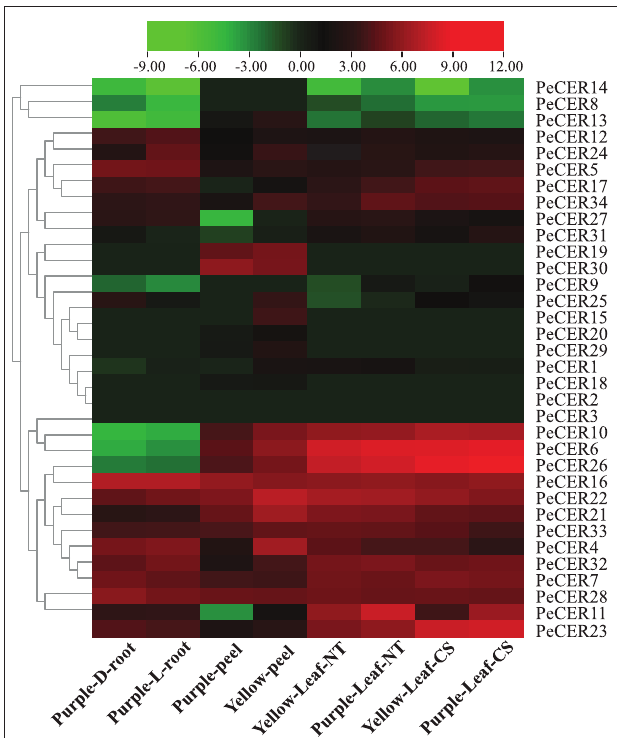
FIGURE 11 | Expression profiles of PeCER genes in roots, peels, and leaves of yellow and purple passion fruit cultivars under different conditions. L and D represent the samples from limestone (L) and sandy dolomite (D) rocky desertification areas. NT and CS indicate the normal temperature (NT) and chilling stress (CS) conditions. FPKM values were transformed by log2, and heatmap was constructed with the TBTools software. The red color shows the highest and the blue color shows the lowest expression levels in expression